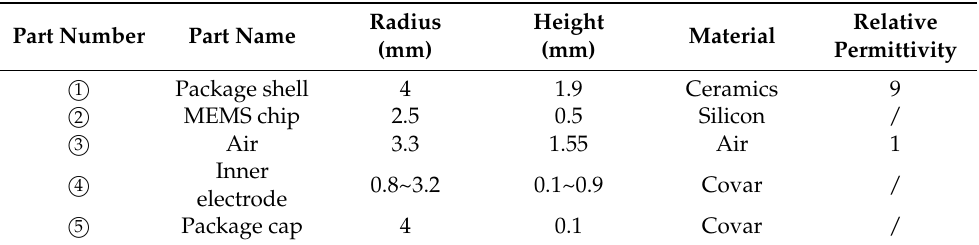
Table 1. Parameters in the simulation